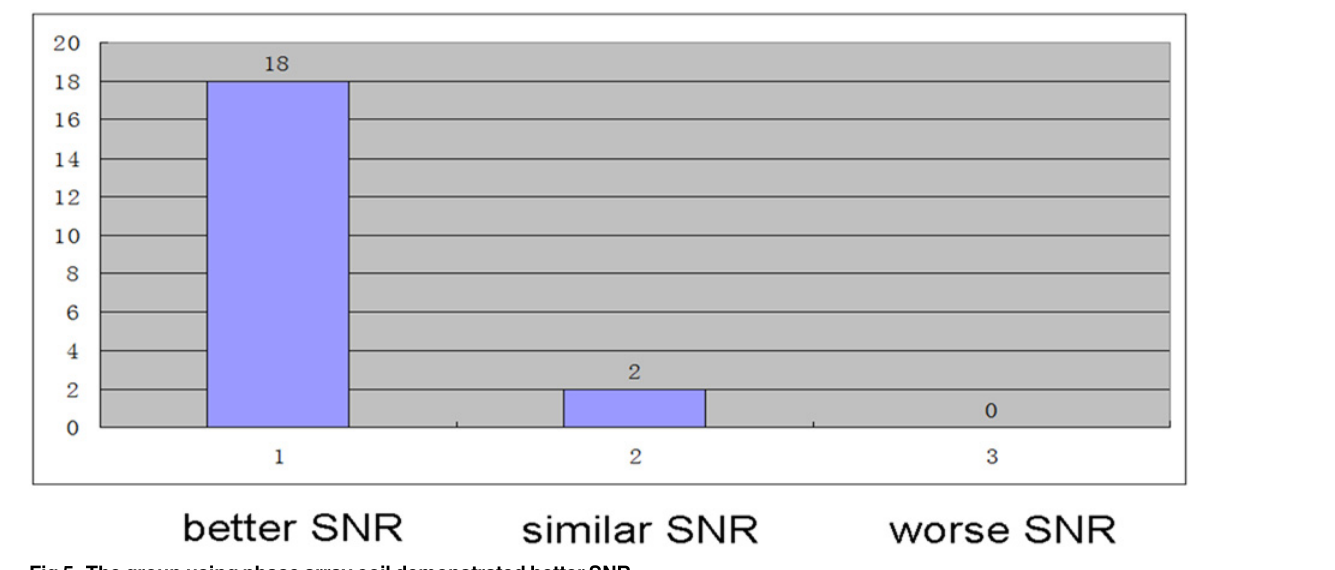
Fig 5. The group using phase array coil demonstrated better SNR.